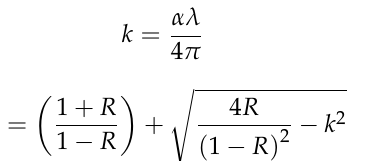
Figure 8. Experimental calculations of bandgap energies for [PoPDA] TF and [PoPDA/TiO 2 ] MNC thin films.